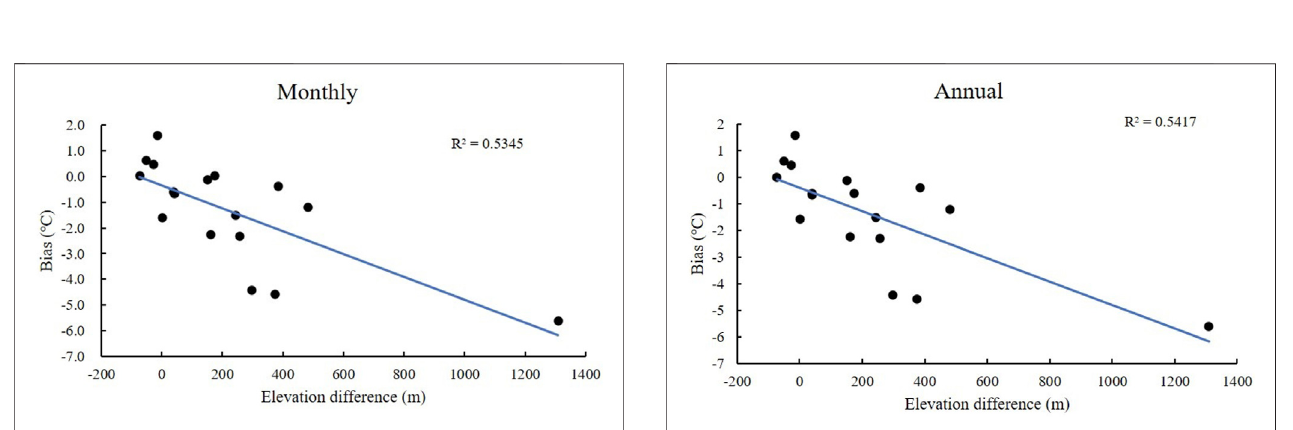
Frontiers in Earth Science |